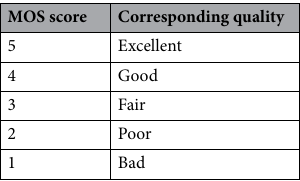
Table 1. MOS score quality equivalence.